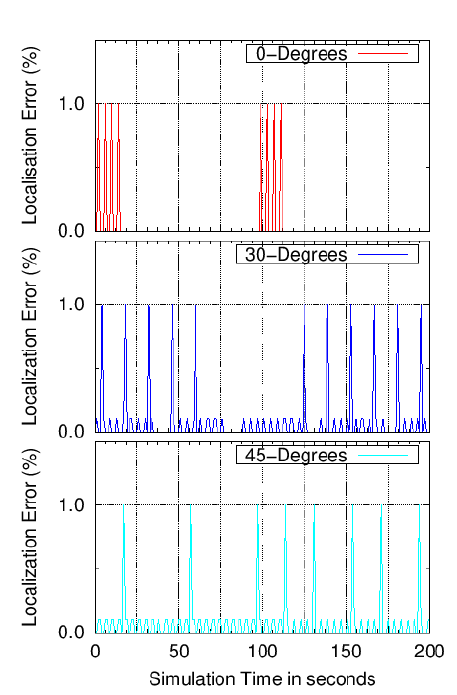
Figure 18. Localization error variation with simulation time